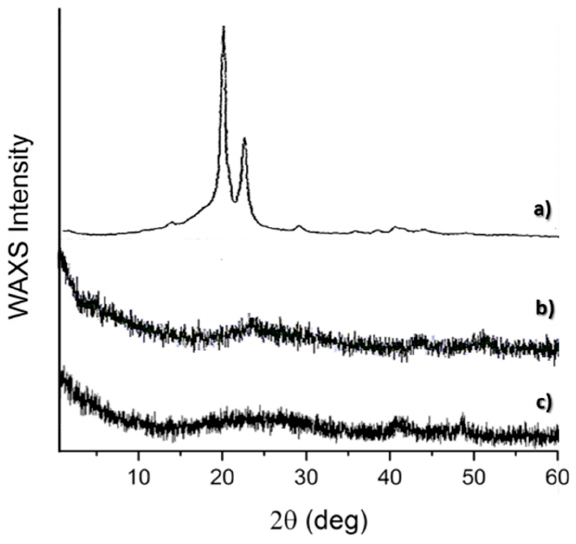
Figure 4. XRD spectra of ( a ) PCL, ( b ) TiO 2 gel and ( c ) TiO 2 /PCL gel.